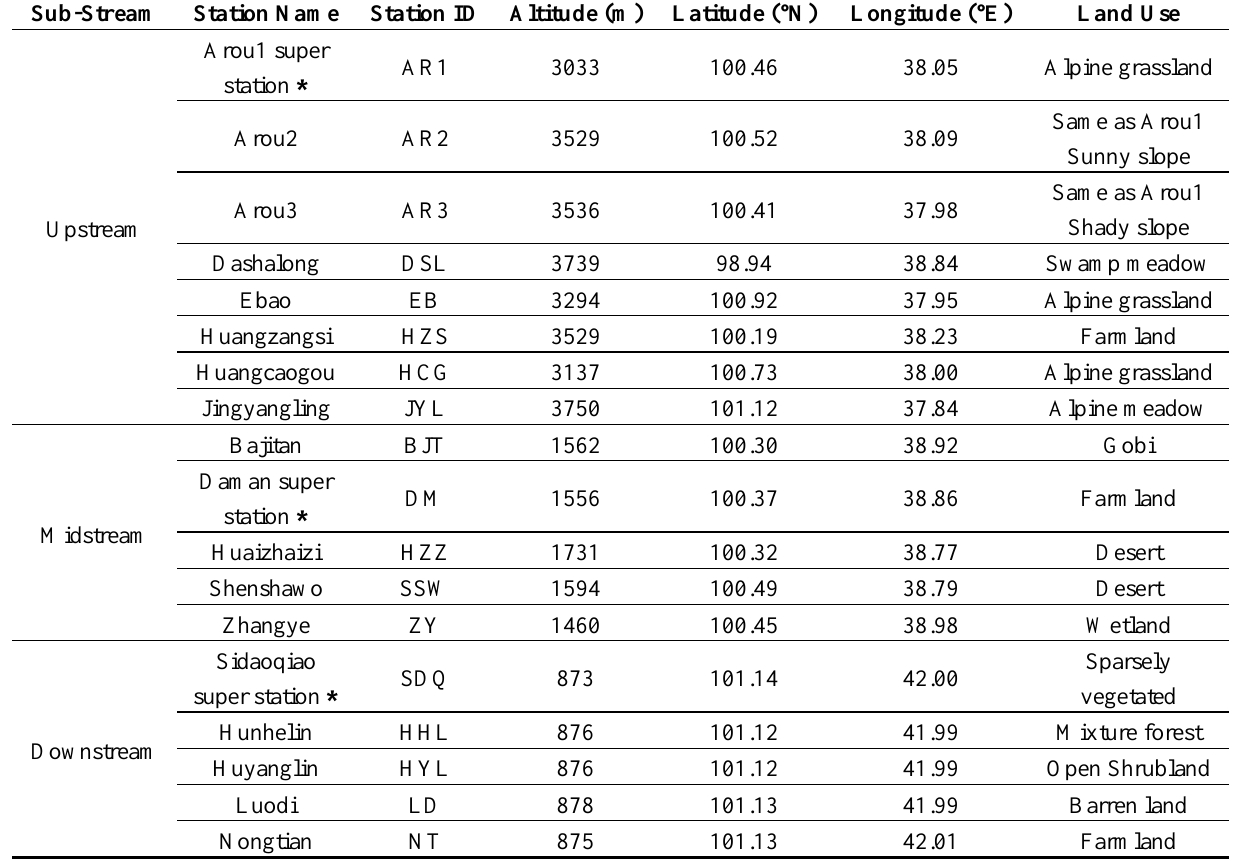
Table 1. Charateristics of HiWATER (Heihe Watershed Allied Telemetry Experimental Research) meteorological stations over HRB (Heihe River